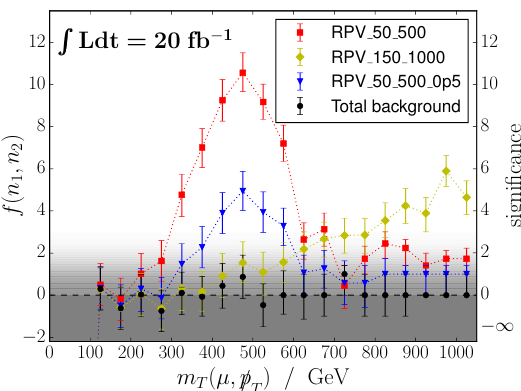
Figure 2. The left-hand axis shows the median value of the statistic f ( n 1 ; n 2 ) in each 50 GeV bin of m T ( (cid:22); =p ), while the right-hand axis shows the mapping of these values to ‘sigmas signi(cid:12)cance’ T using the blue line of (cid:12)gure 3. The black points show background alone, and the coloured points show the sum of the background with each of the example signals. Error bars indicate the 50 percentile values of f , i.e. the 1 (cid:27) deviations from the median. The shaded region indicates the (cid:6) null hypothesis of f ( n 1 ; n 2 ) 0 and unit variance upwards. The dotted lines connecting points (cid:20)